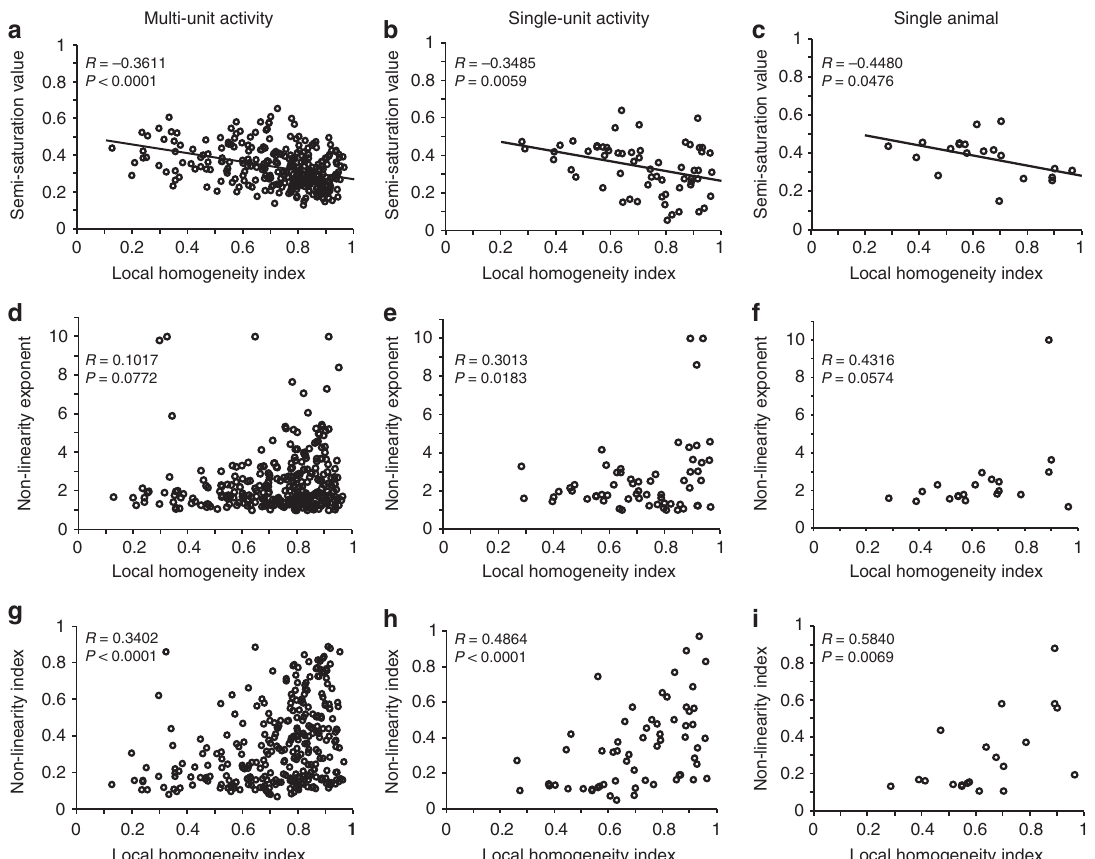
Figure 3 | Association between response contrast nonlinearity and cortical orientation topography. Left column: multi-unit activity ( N ¼ 303; 6 cats). Middle column: single neuron activity ( N ¼ 61; 6 cats). Right column: single neuron activity for one cat ( N ¼ 20). ( a – c ) Semi-saturation value as a function of local orientation homogeneity. Black lines depict best-fitting linear regression. ( d – f ) Exponent of Naka–Rushton fit as a function of local orientation homogeneity. ( g – i ) Nonlinearity Index (a value closer to 1 corresponds to a less linear response and a value closer to 0 corresponds to a more linear response) as a function of local orientation